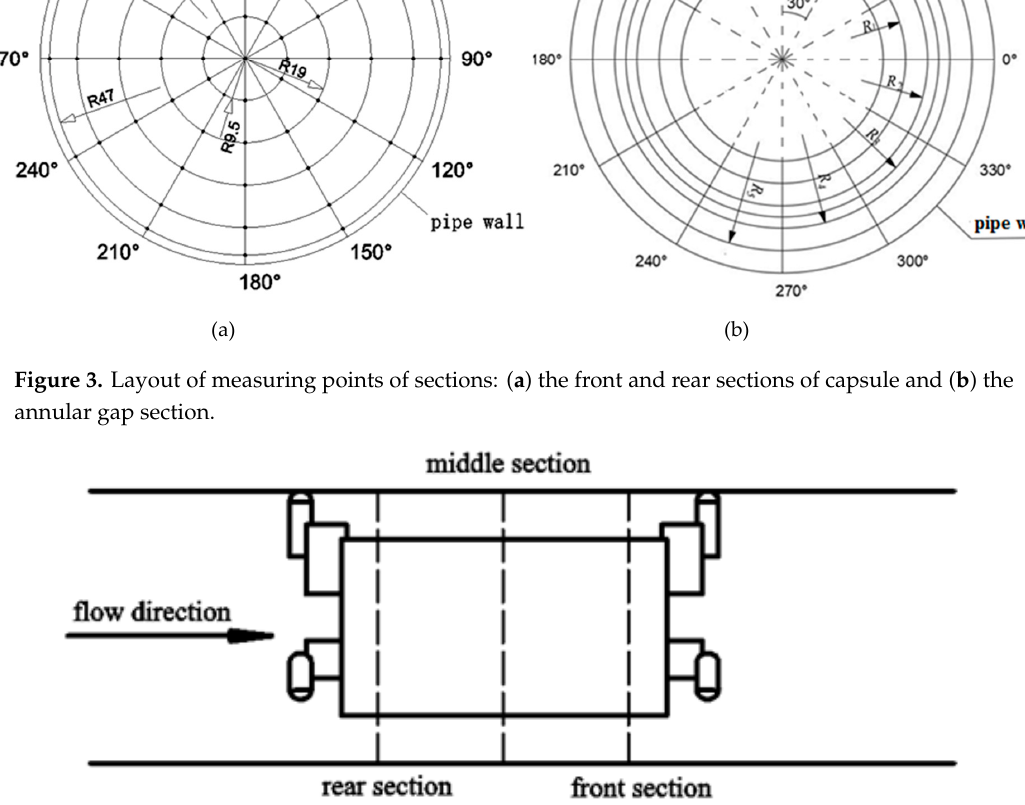
Figure 4. Schematic diagram of annular gap section division of capsule.